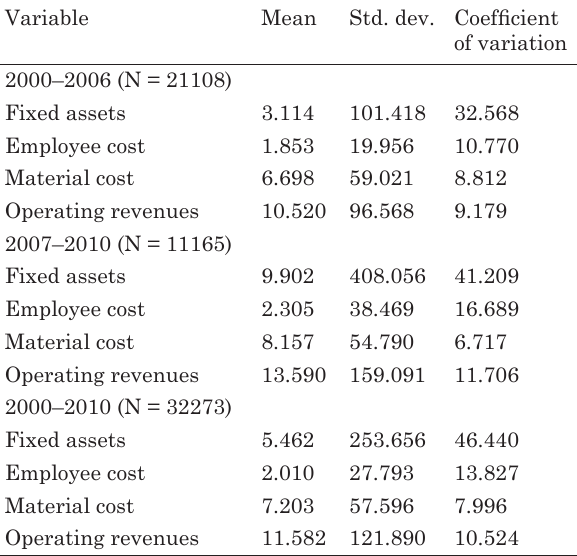
Table 1. Descriptive statistics of input-output data, pre- and post-financial crisis, constant 2000 prices, mln euro